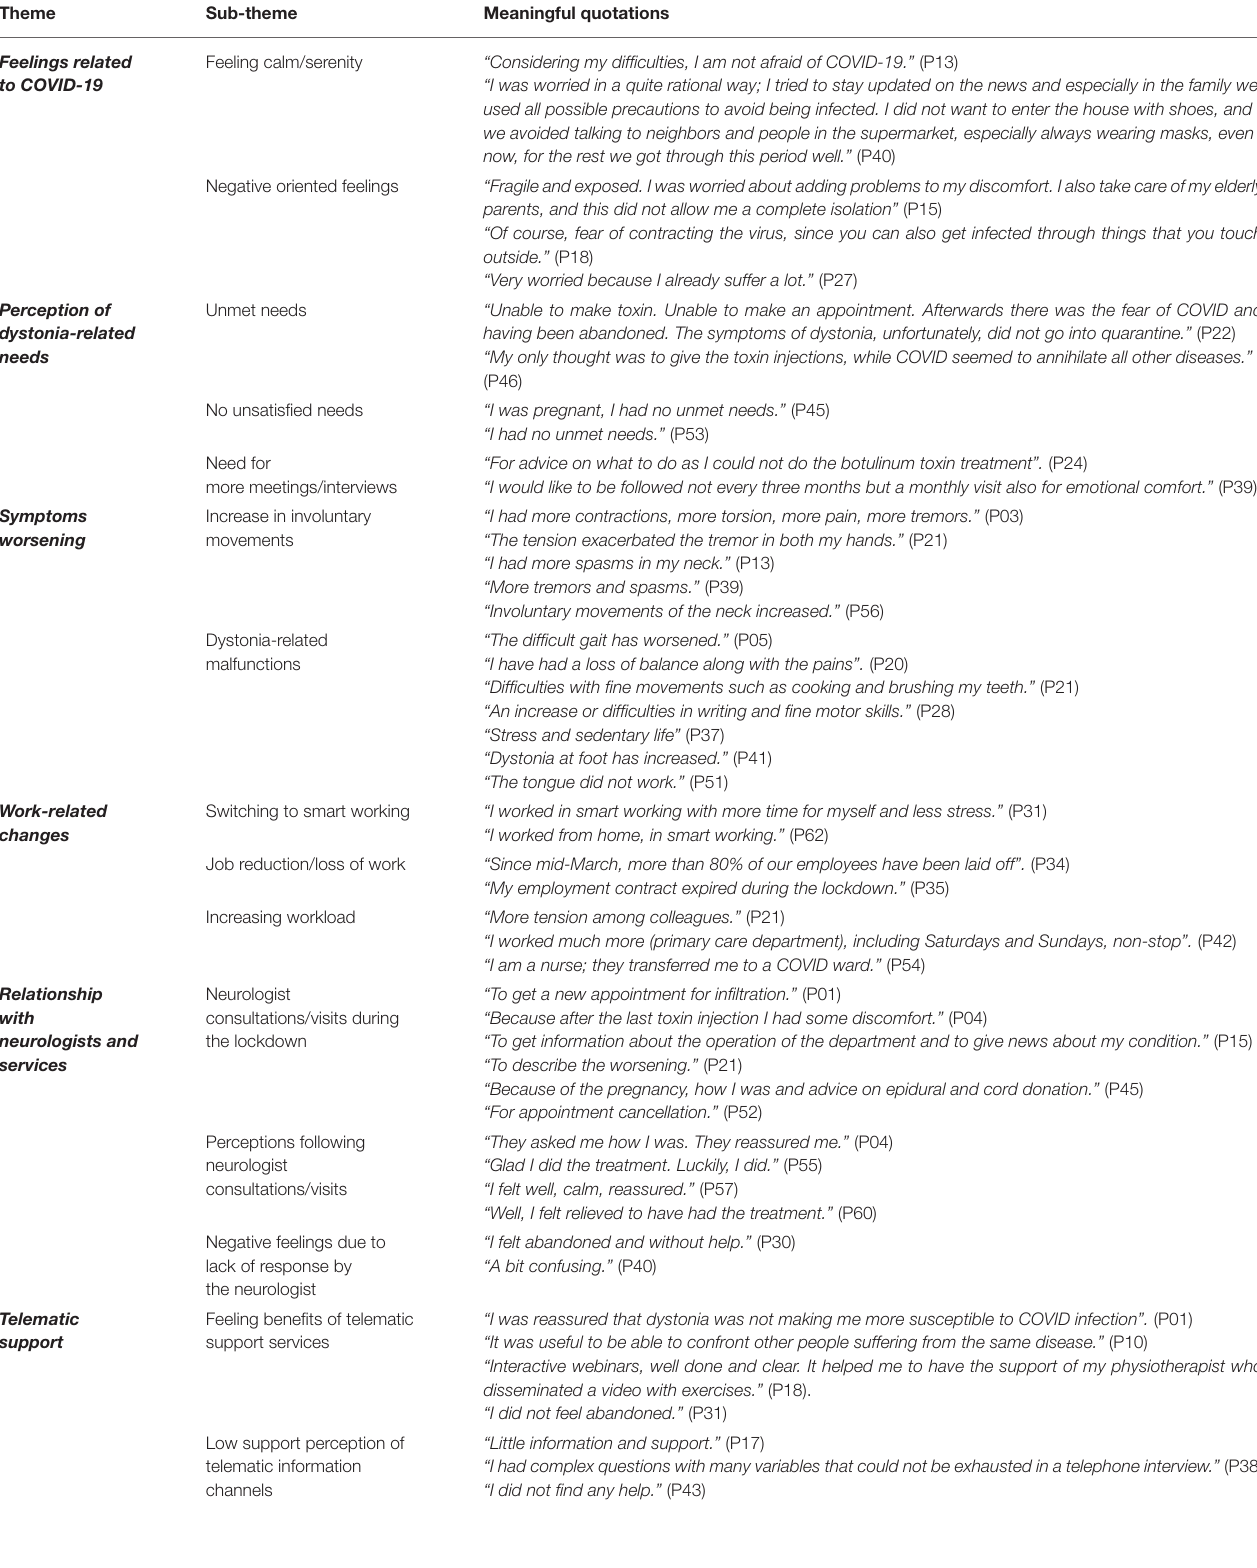
TABLE 3 | Themes, sub-themes and meaningful